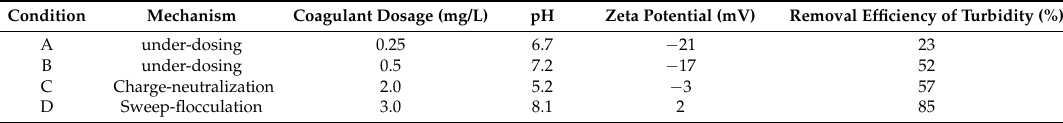
Table 2. Selected coagulation conditions of in-line